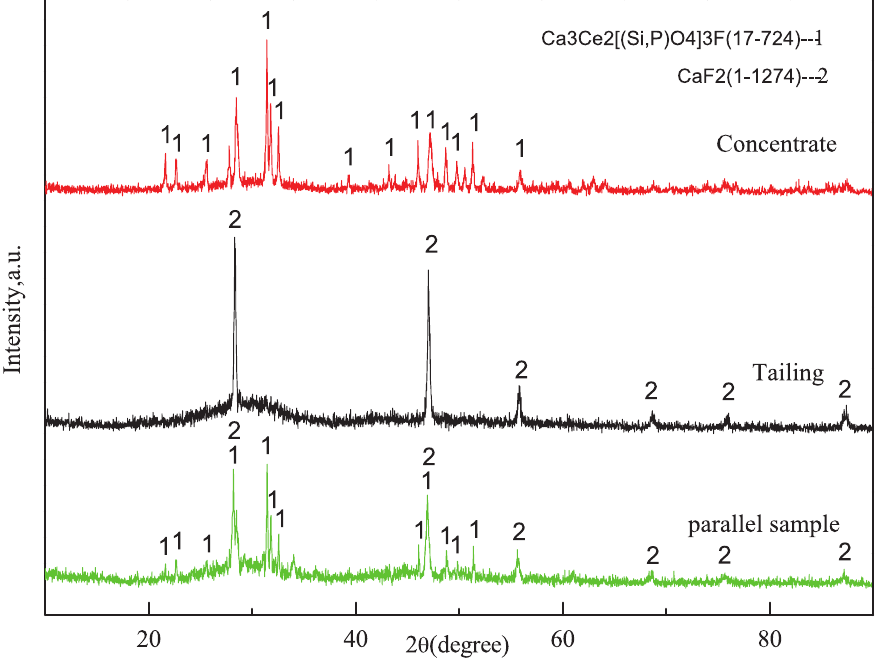
Fig. 6: X-ray diffraction of the samples obtained by centrifugal separation compared with the parallel